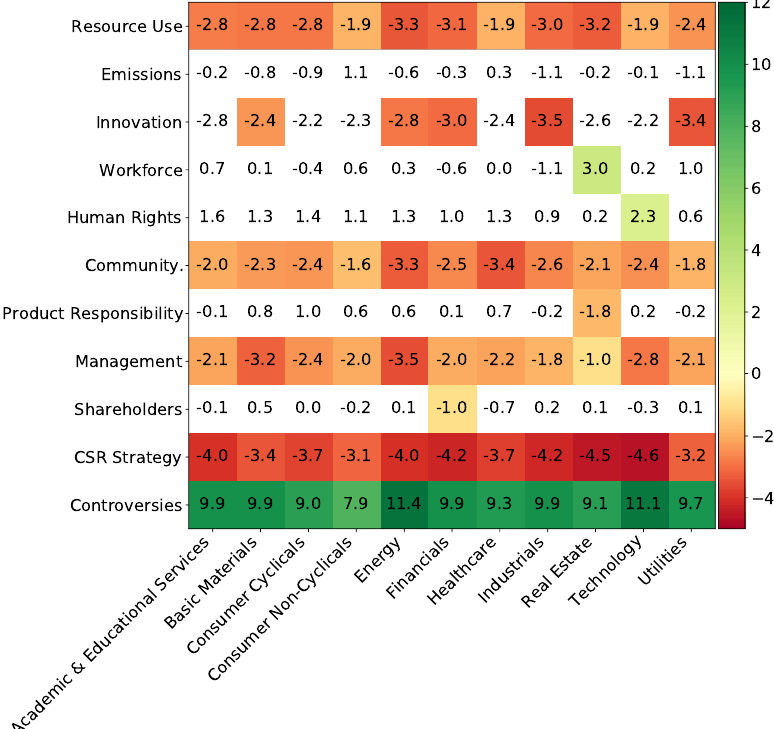
Figure 13. Materiality matrix: marginal effects of the combination ESG feature/Sector feature on the predicted probability of having a positive return. Blank cells are those that were not found to be statistically significant by the Benjamini–Hochberg